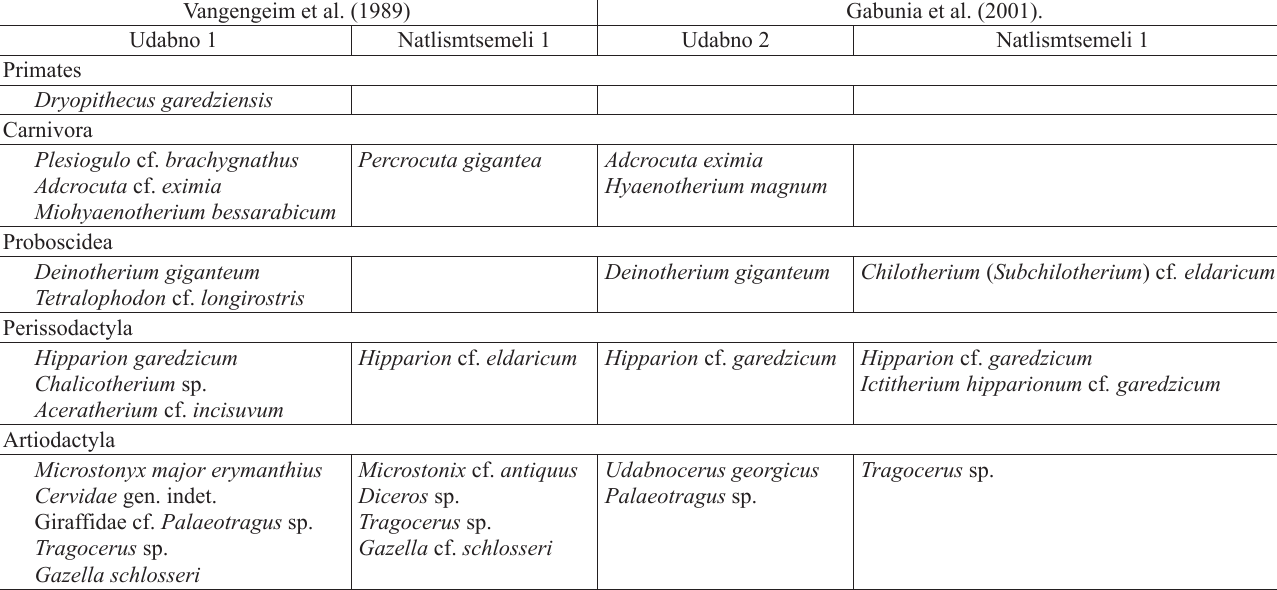
Table 6. Udabno faunal lists according to Vangengeim et al. (1989) and Gabunia et al. (2001). Vangengeim et al.